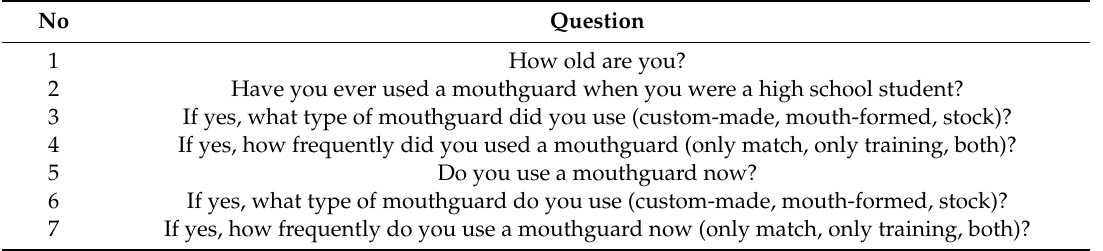
Table 1. Questionnaire.